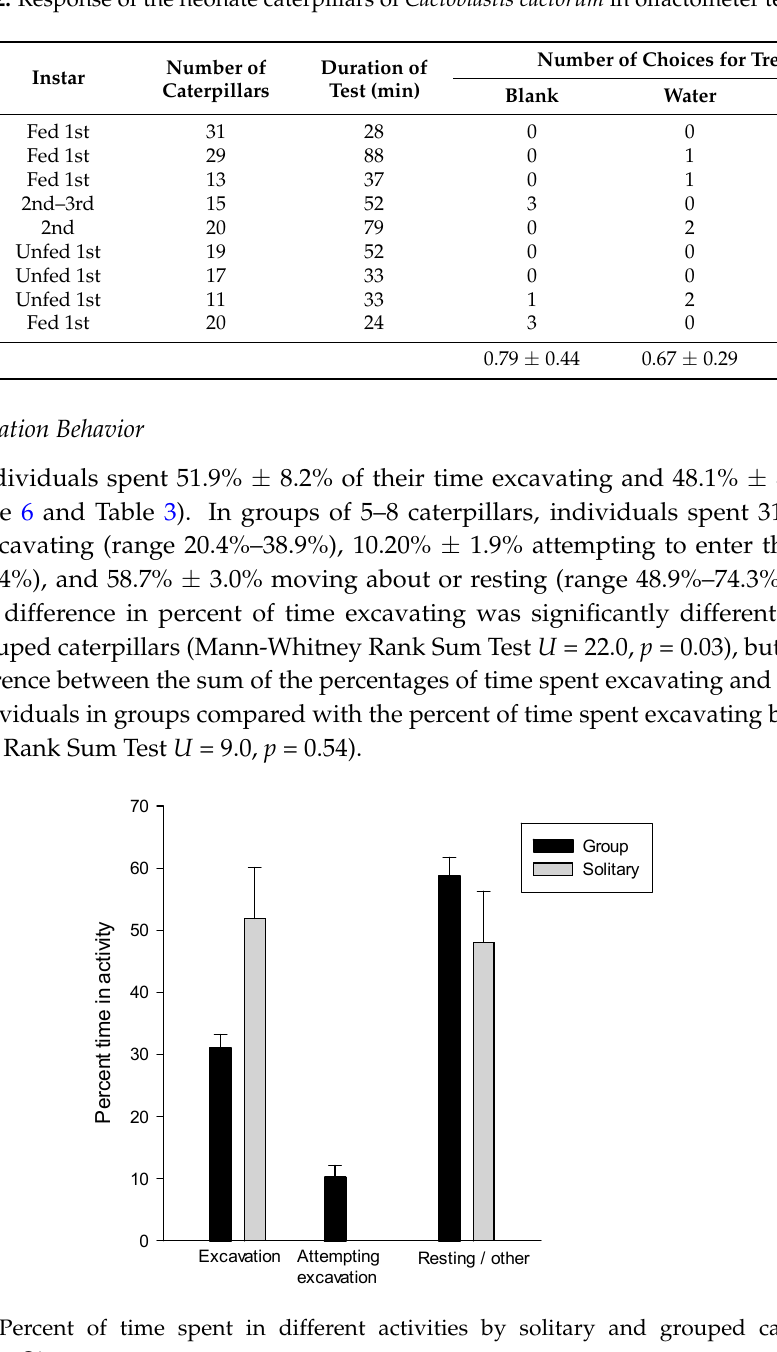
Table 2. Response of the neonate caterpillars of Cactoblastis cactorum in olfactometer tests.